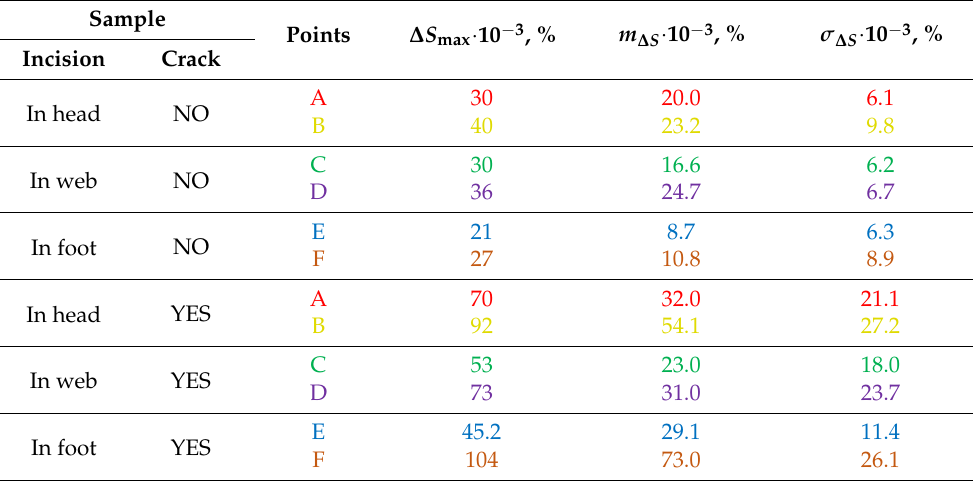
Table 2. Comparison of DIC and FEM